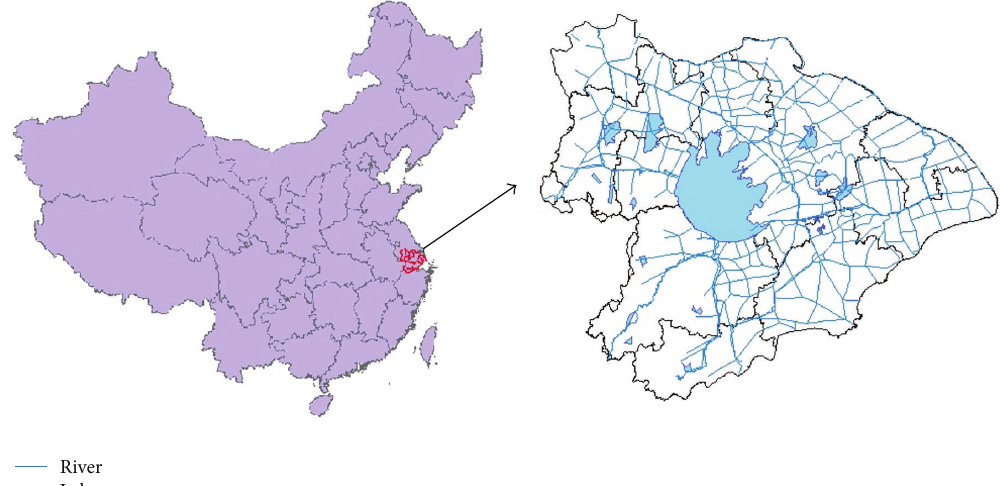
Figure 1: The location of the Taihu Basin.